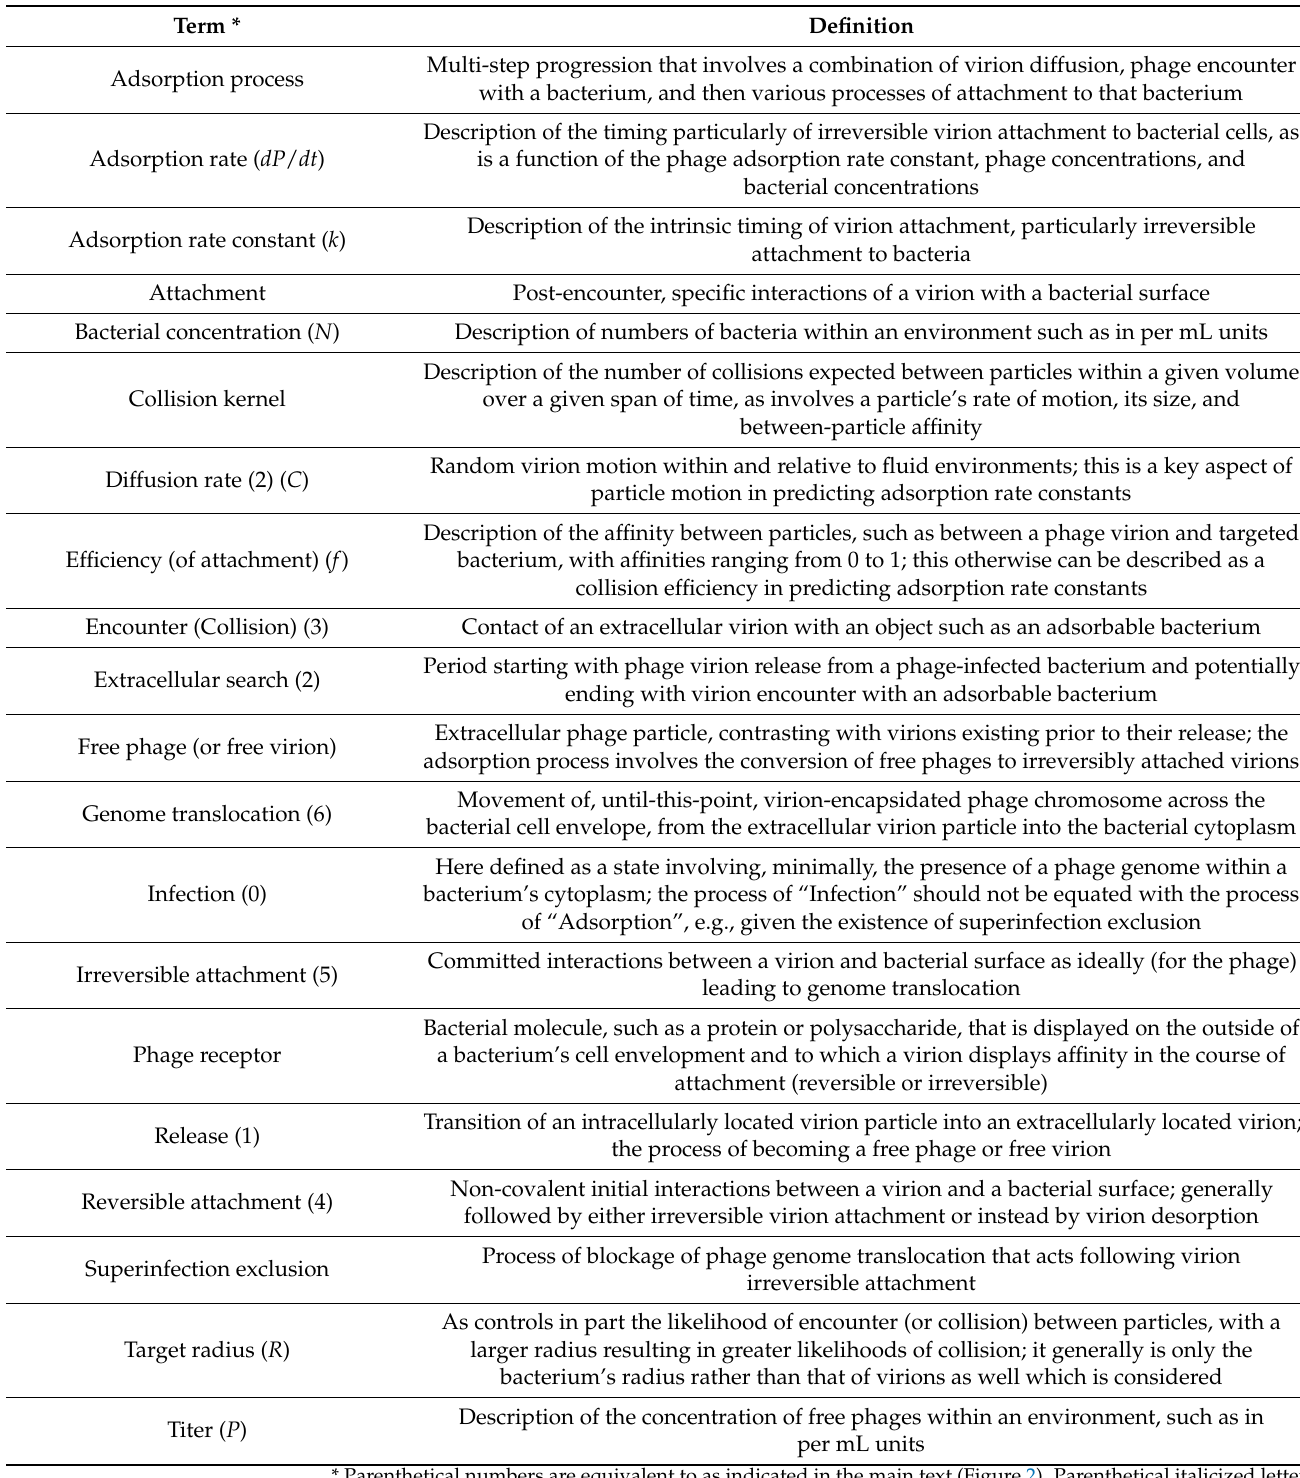
Table 1. Definitions of terms relevant to phage adsorption